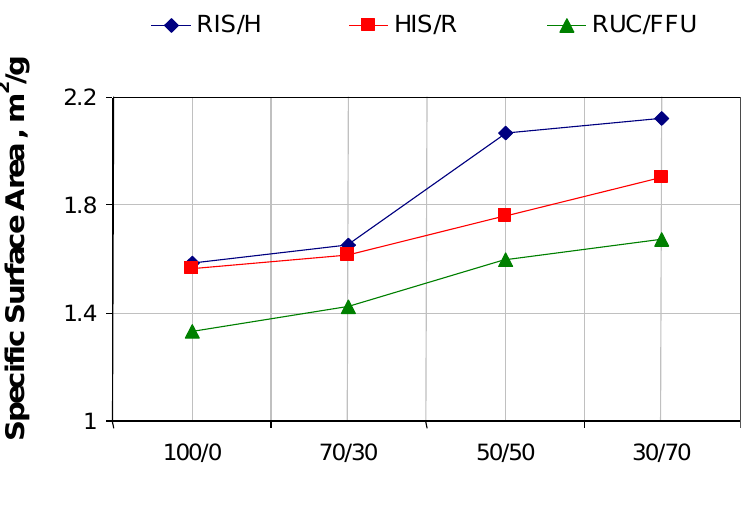
Figure 2. Specific surface area in relation with pulp